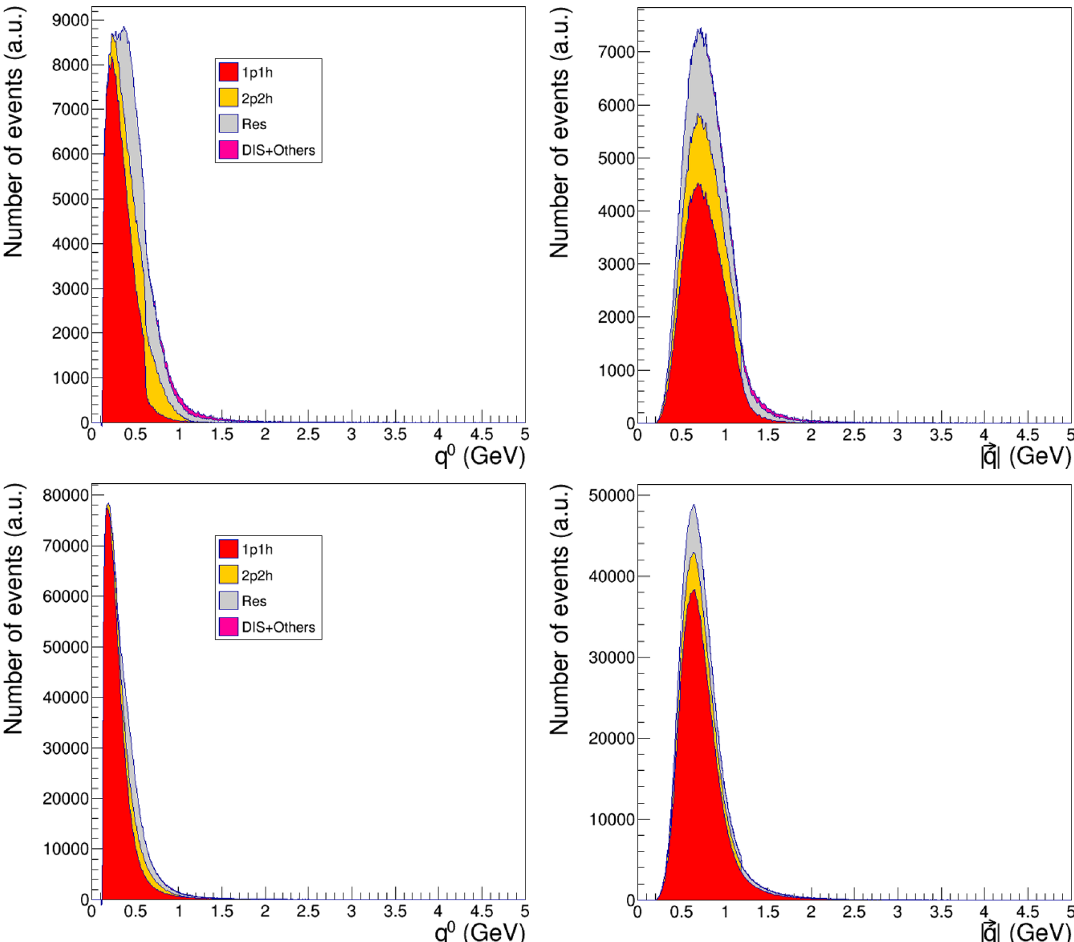
Figure 27 . The same as figure 25 for CC0 π 1p